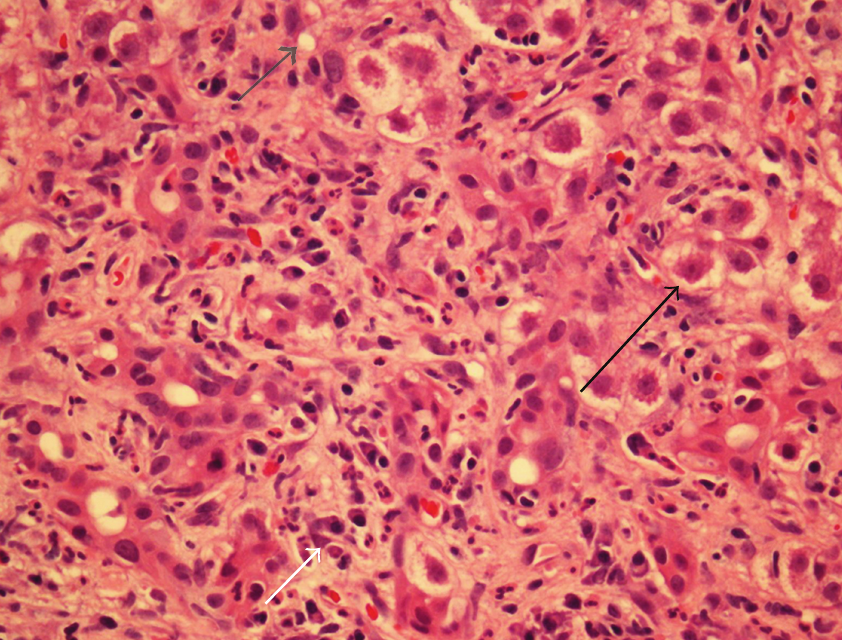
Figure 1: Liver biopsy showing severe acute hepatitis with mixed inflammatory portal tract infiltrate (white arrow), patchy hepatocyte ballooning degeneration (black arrow), and extensive periportal hepatocyte dropout (grey